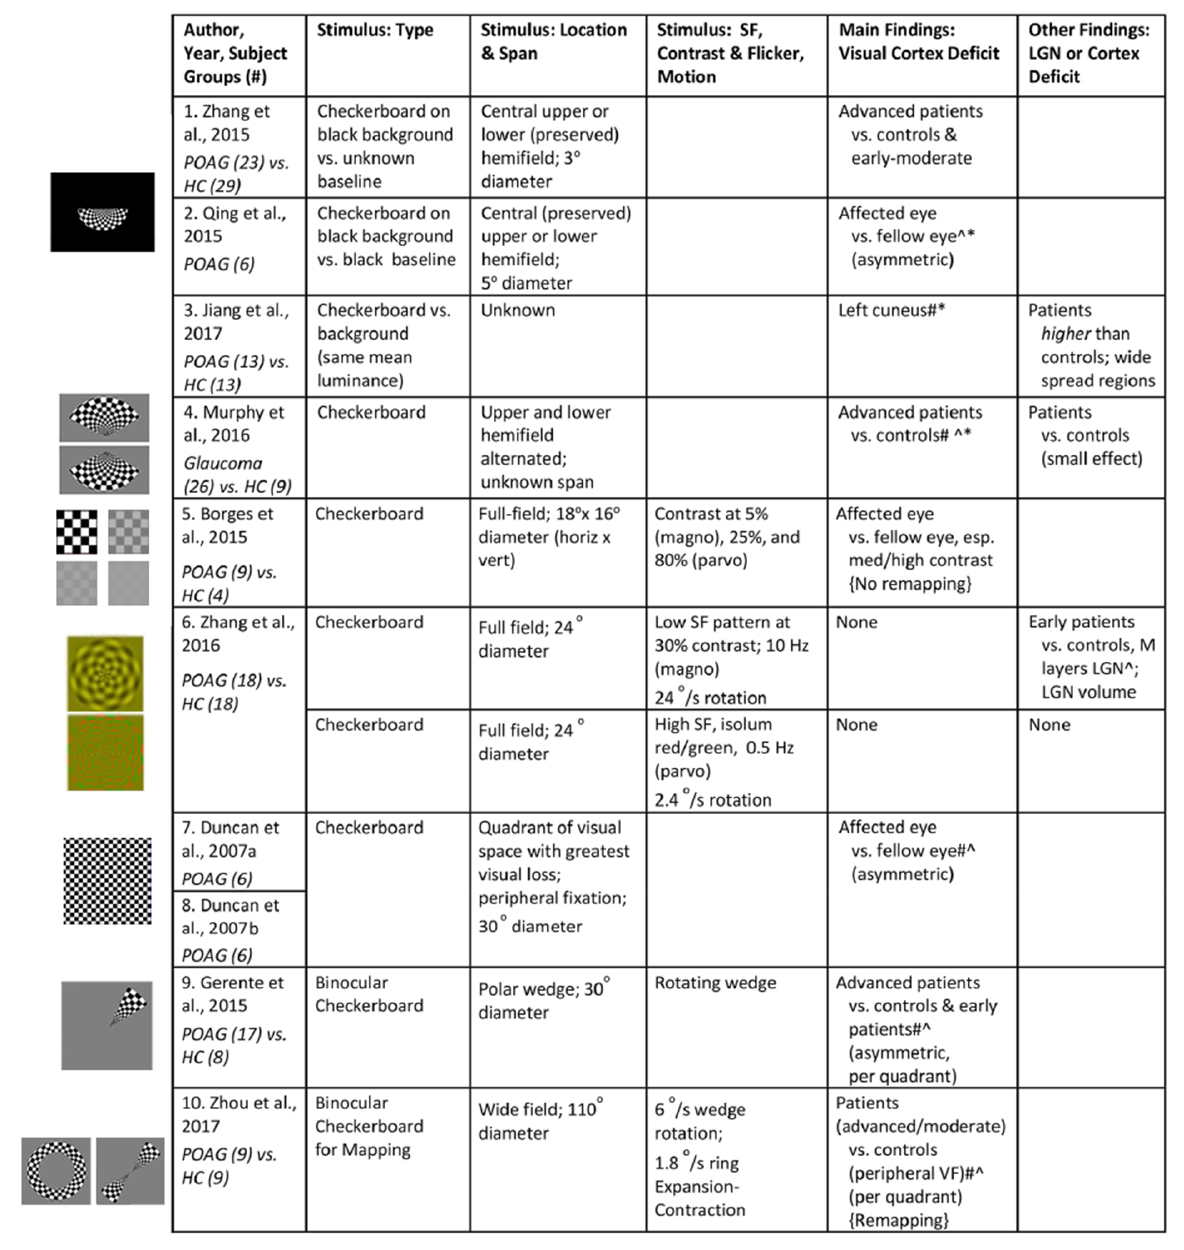
activity of the bilateral occipital lobe has been reported.